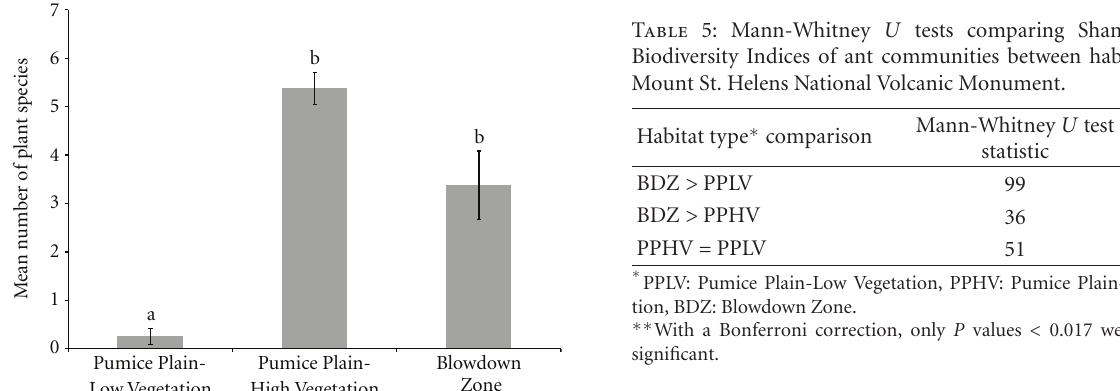
Figure 6: Percent ground cover by plants (mean percent ground cover ± 1 SE) in three habitat types at Mount St. Helens National Volcanic Monument sampled between 22 and 25 July 2008. Di ff erent letters above the bars indicate significant di ff erences ( P < 0 . 01) between habitat types.